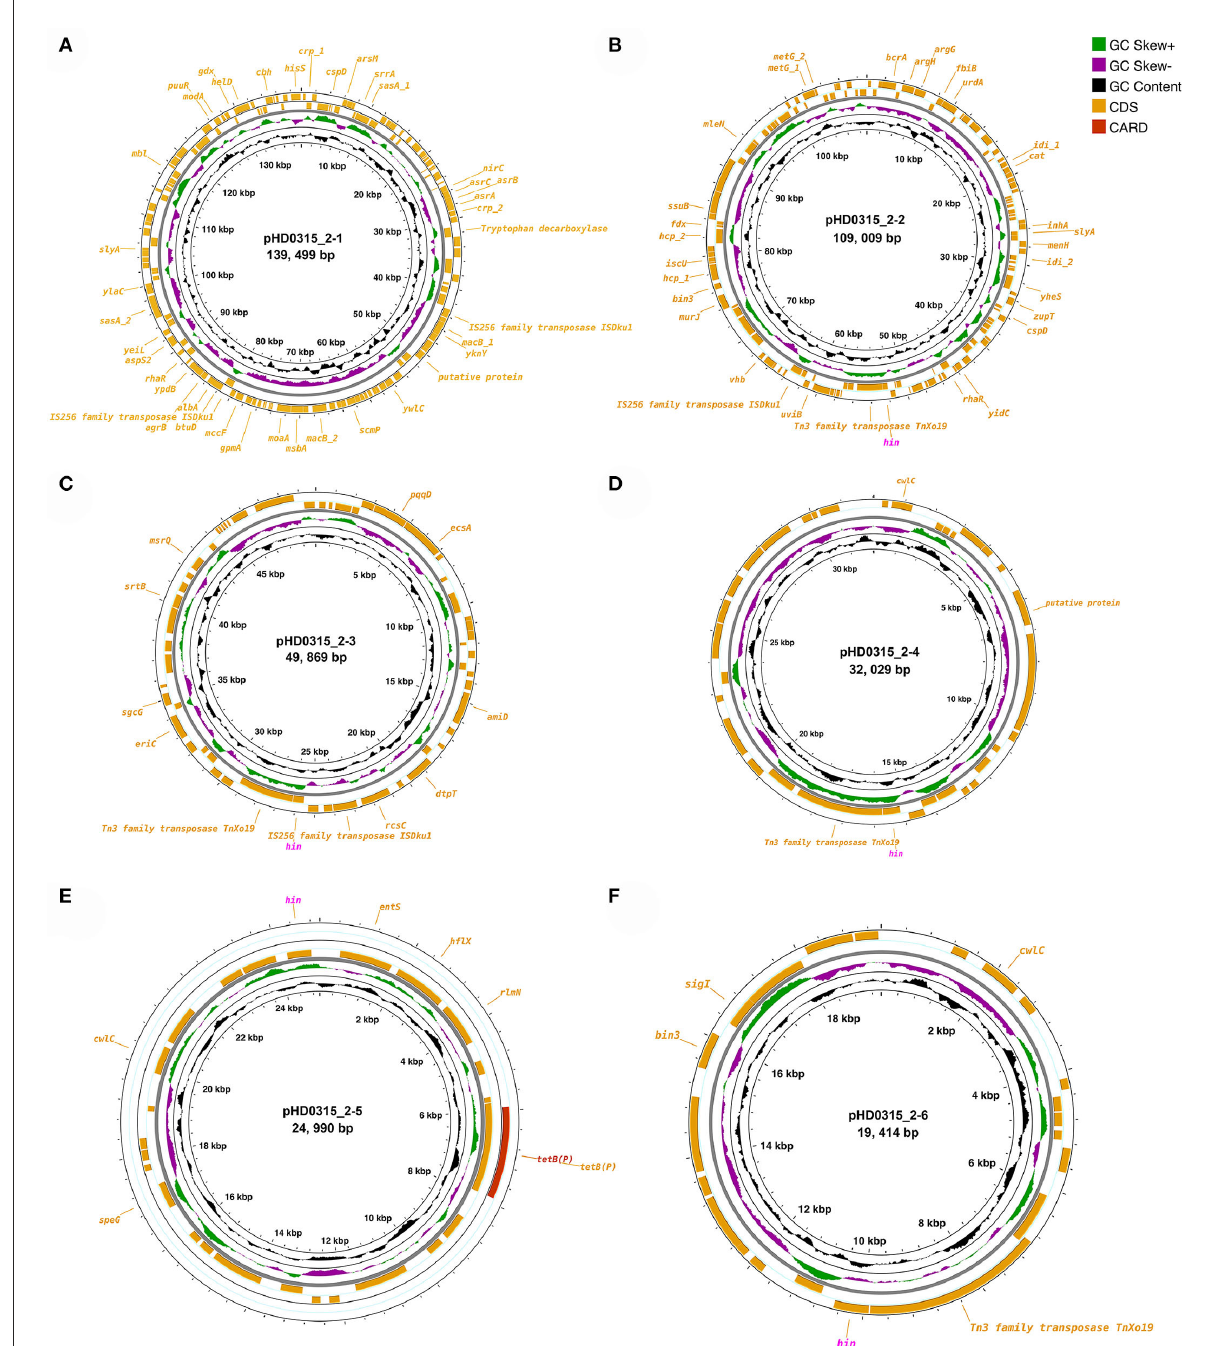
FIGURE2 Circular display of the plasmids identified in P. bifermentans HD0315_2. (A–F) From outer to inner rings: antibiotic-resistant gene based on CARD annotation, CDSs on the forward/reverse strand, GC skew, and GC content. CDSs labeled with magenta color are genes ( hin ) coding Hin DNA invertase. CDSs without a label are genes coding hypothetical